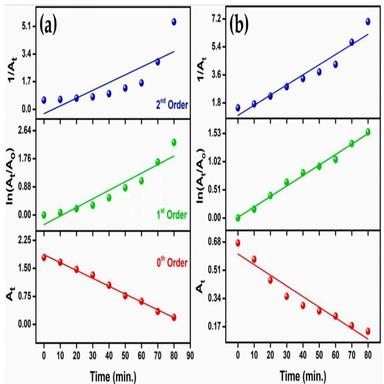
Evaluation of degradation reaction kinematics of (a) Rh–B and (b) MB dyes against 60 mg of SCD5 catalyst.